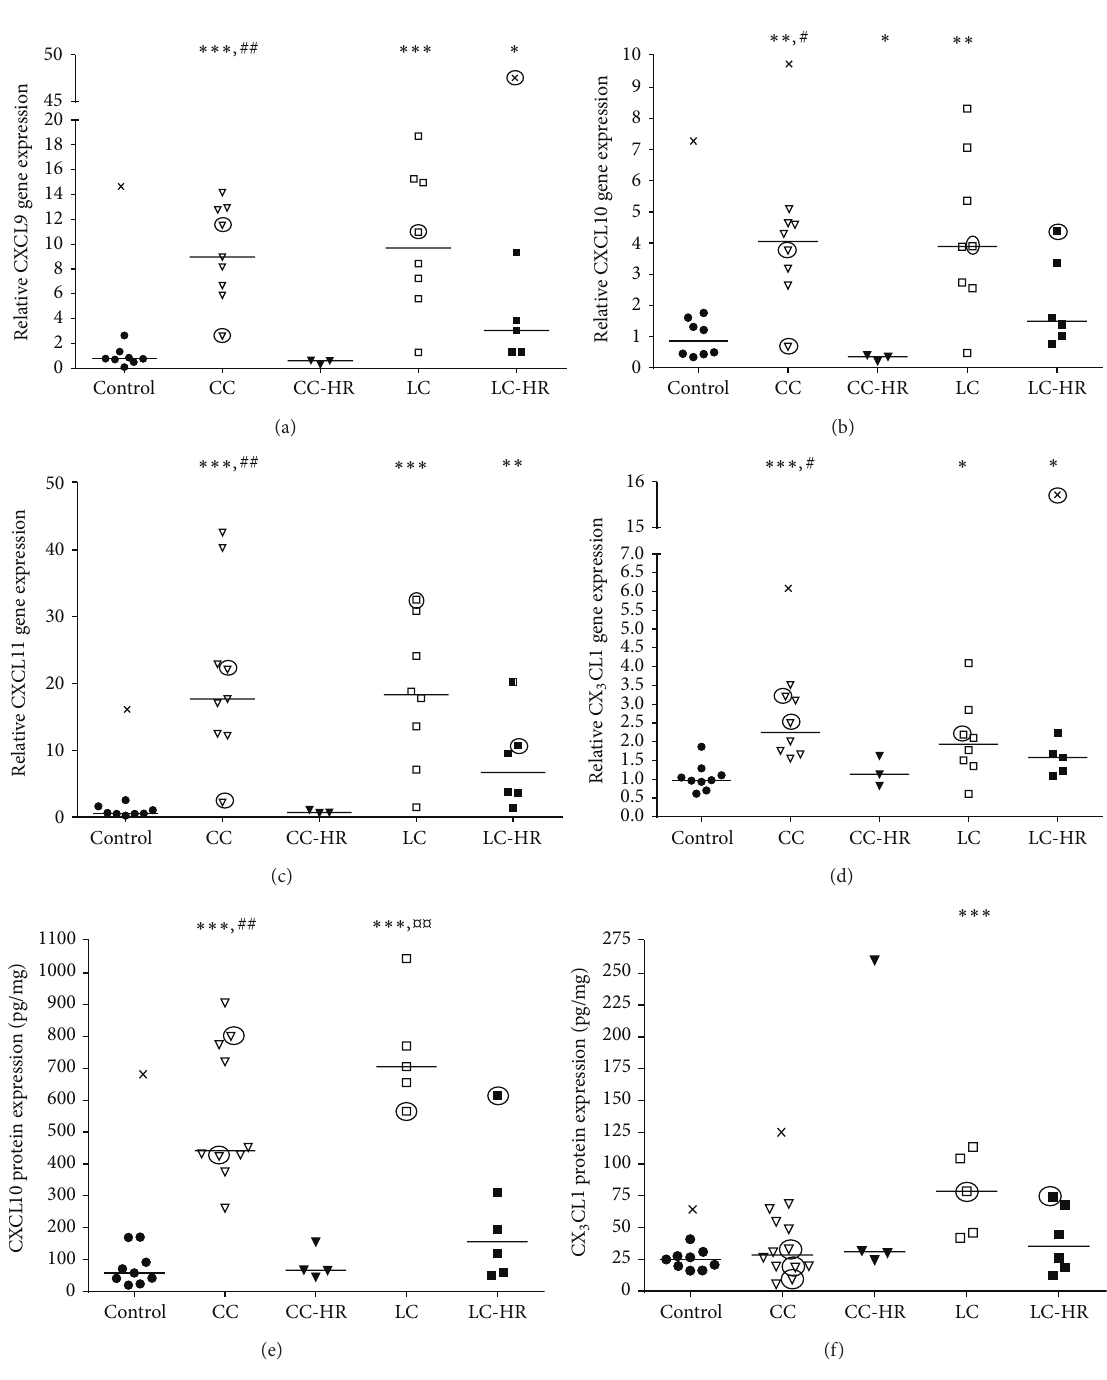
Figure 2: Gene and protein expressions of the Th1 and CD8 + T cell recruiting chemokines CXCL9, CXCL10, CXCL11, and CX 3 CL1. Each symbol represents onepatient and themedians of thevalues aredepicted as a line. Statistical outliersare marked as crosses(X)and budesonide treated patients are encircled. ∗ 𝑃 < 0.05 , ∗∗ 𝑃 < 0.01 , and ∗∗∗ 𝑃 ≤ 0.001 versus controls, # 𝑃 < 0.05 , ## 𝑃 < 0.01 versus CC-HR, and ¤ 𝑃 < 0.05 , ¤¤ 𝑃 < 0.01 versus